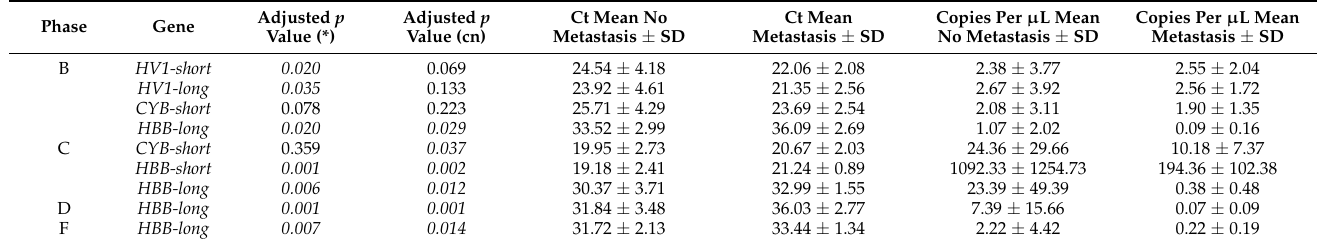
Table 3. Representation of the values for risk of metastasis.